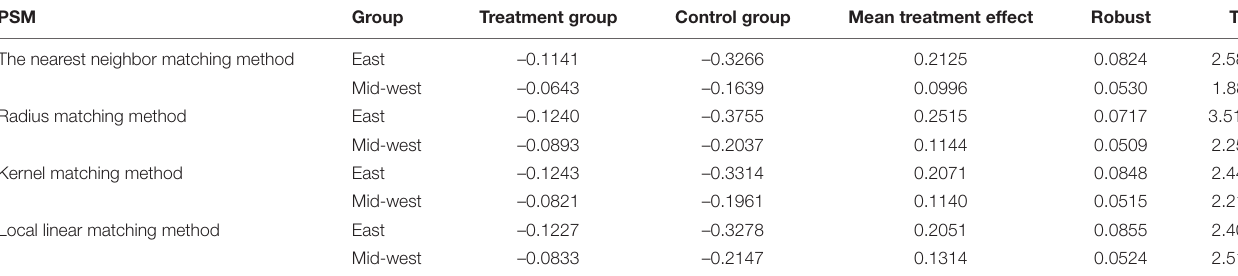
TABLE 8 | The matching estimation results of eastern and central and western villagers’ propensity